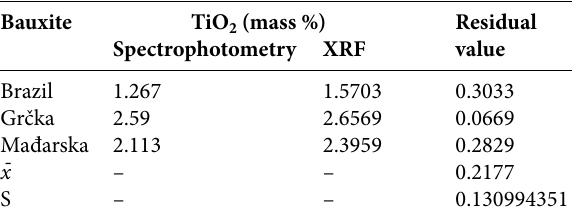
Table 4. The content of TiO 2 in bauxites from different deposits cal- culated using spectrophotometric and XRF method (by pressing) Bauxite TiO 2 (mass %) Residual